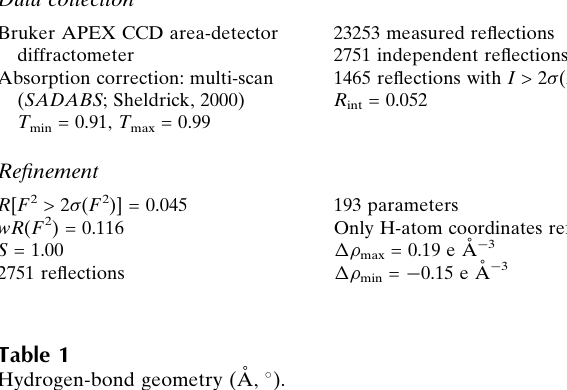
Hydrogen-bond geometry (A˚ , (cid:1)